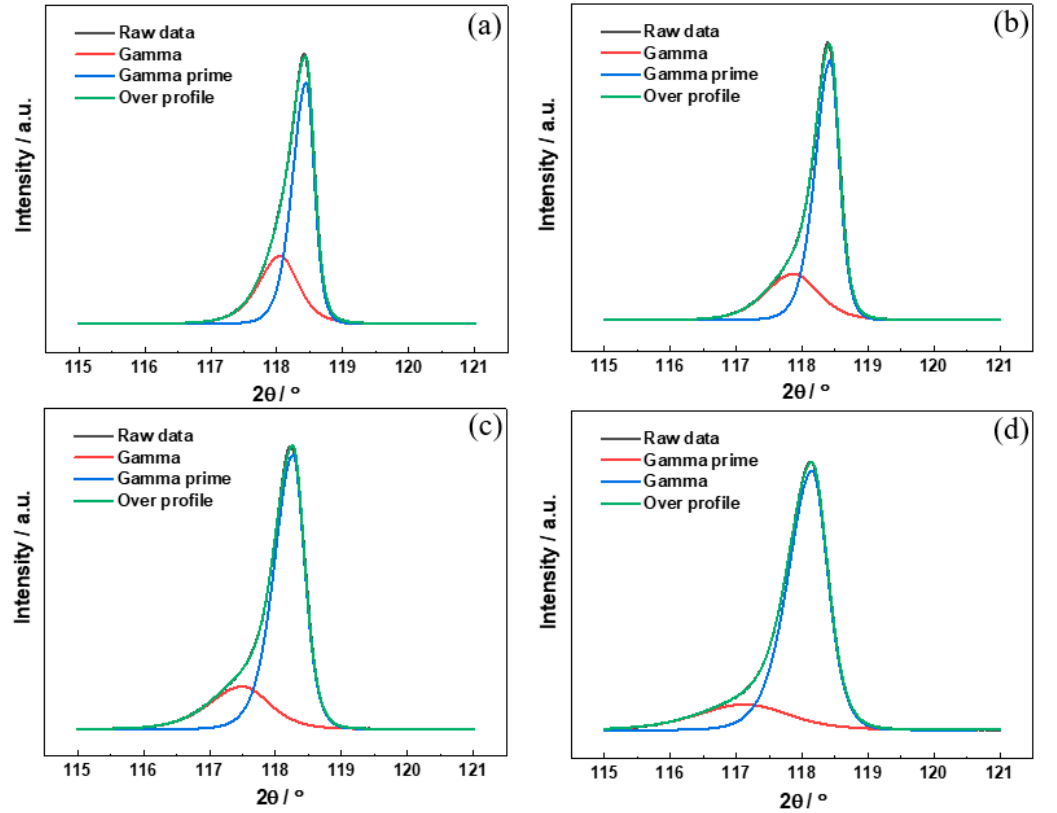
Figure 5. Profiles of (004) diffraction peaks and peak fitting results of the single-crystal alloys with different Mo contents: ( a ) Alloy I, ( b ) Alloy II, ( c ) Alloy III, ( d ) Alloy IV.